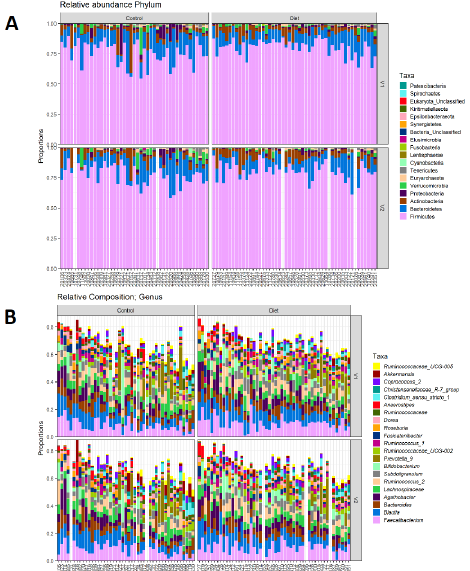
Figure 2. Microbiota composition for each participant. ( A ) Relative abundance of bacterial phyla for each participant, stratified to intervention groups and visits (V1: baseline visit, V2: follow-up visit). Firmicutes are the most abundant, followed by Bacteroidetes , Actinobacteria , and Proteobacteria . ( B ) Same as A, but for 20 most abundant bacterial genera. There are no differences in phylum abundance or genus abundance between groups.